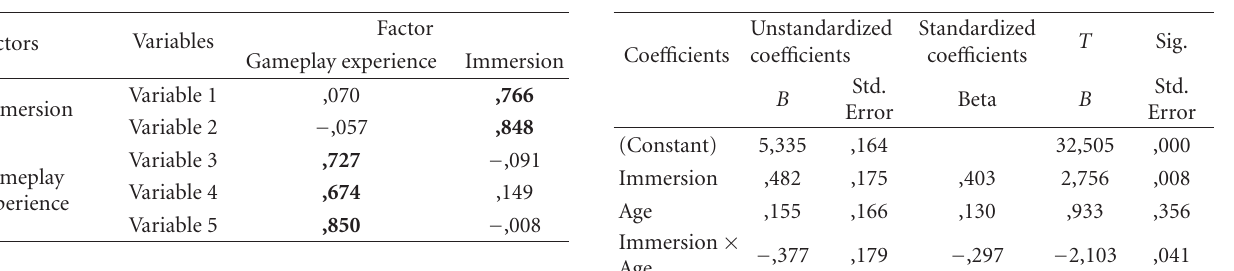
Table 3: Principal component analysis.